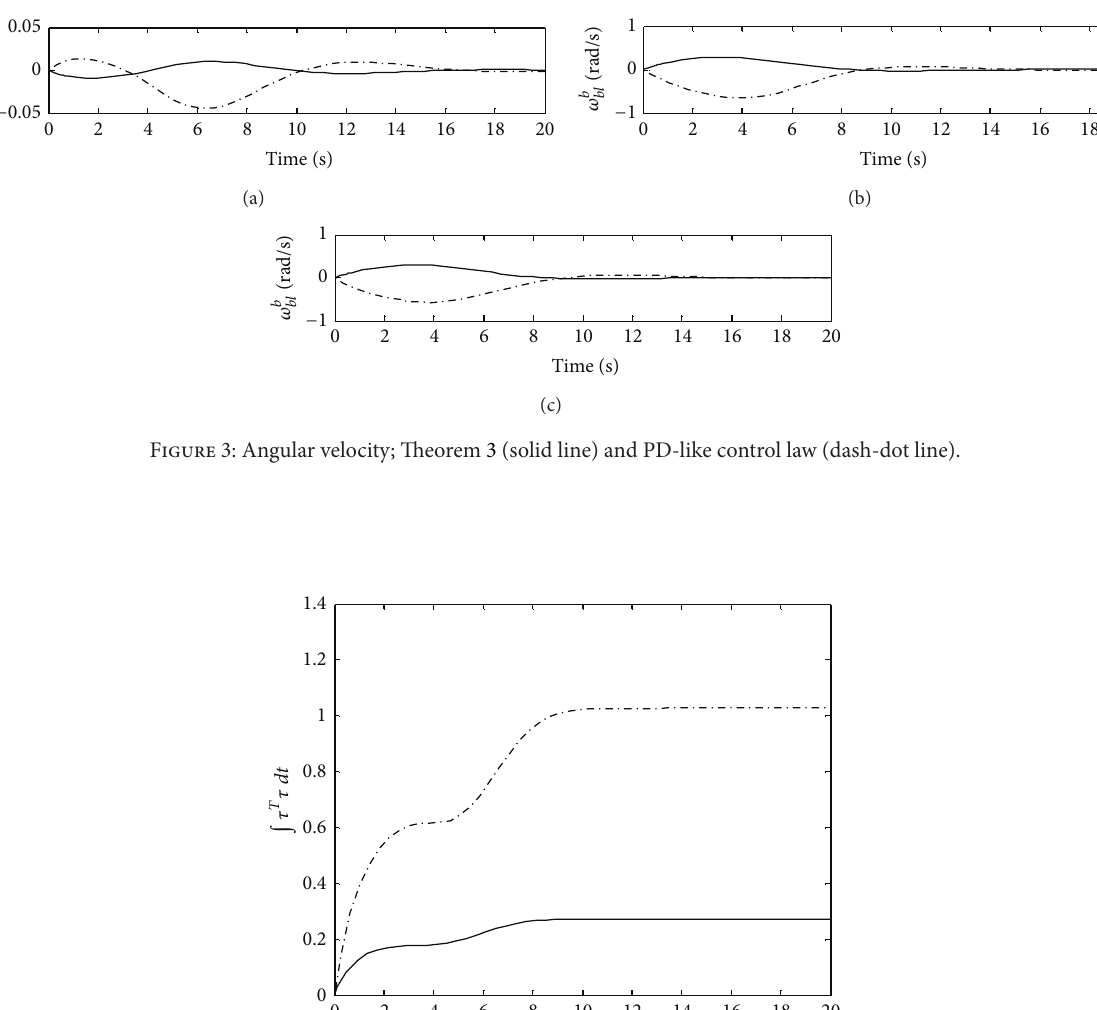
Figure 2: Attitude responses, 𝑞 𝑏𝑑 =[𝜂 𝑏𝑑 𝜀 𝑏𝑑 ]